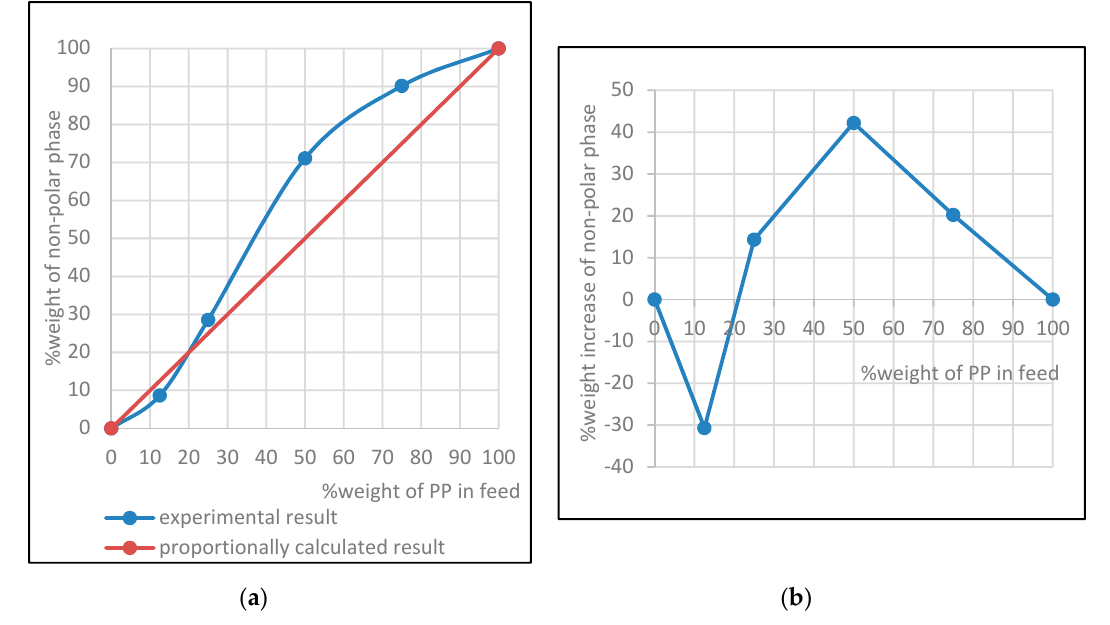
Figure 2. Experimental and theoretical fraction of non-oxygenated phase in bio-oil ( a ), the increase of non-polar fraction obtained experimentally compared to that obtained theoretically ( b ).